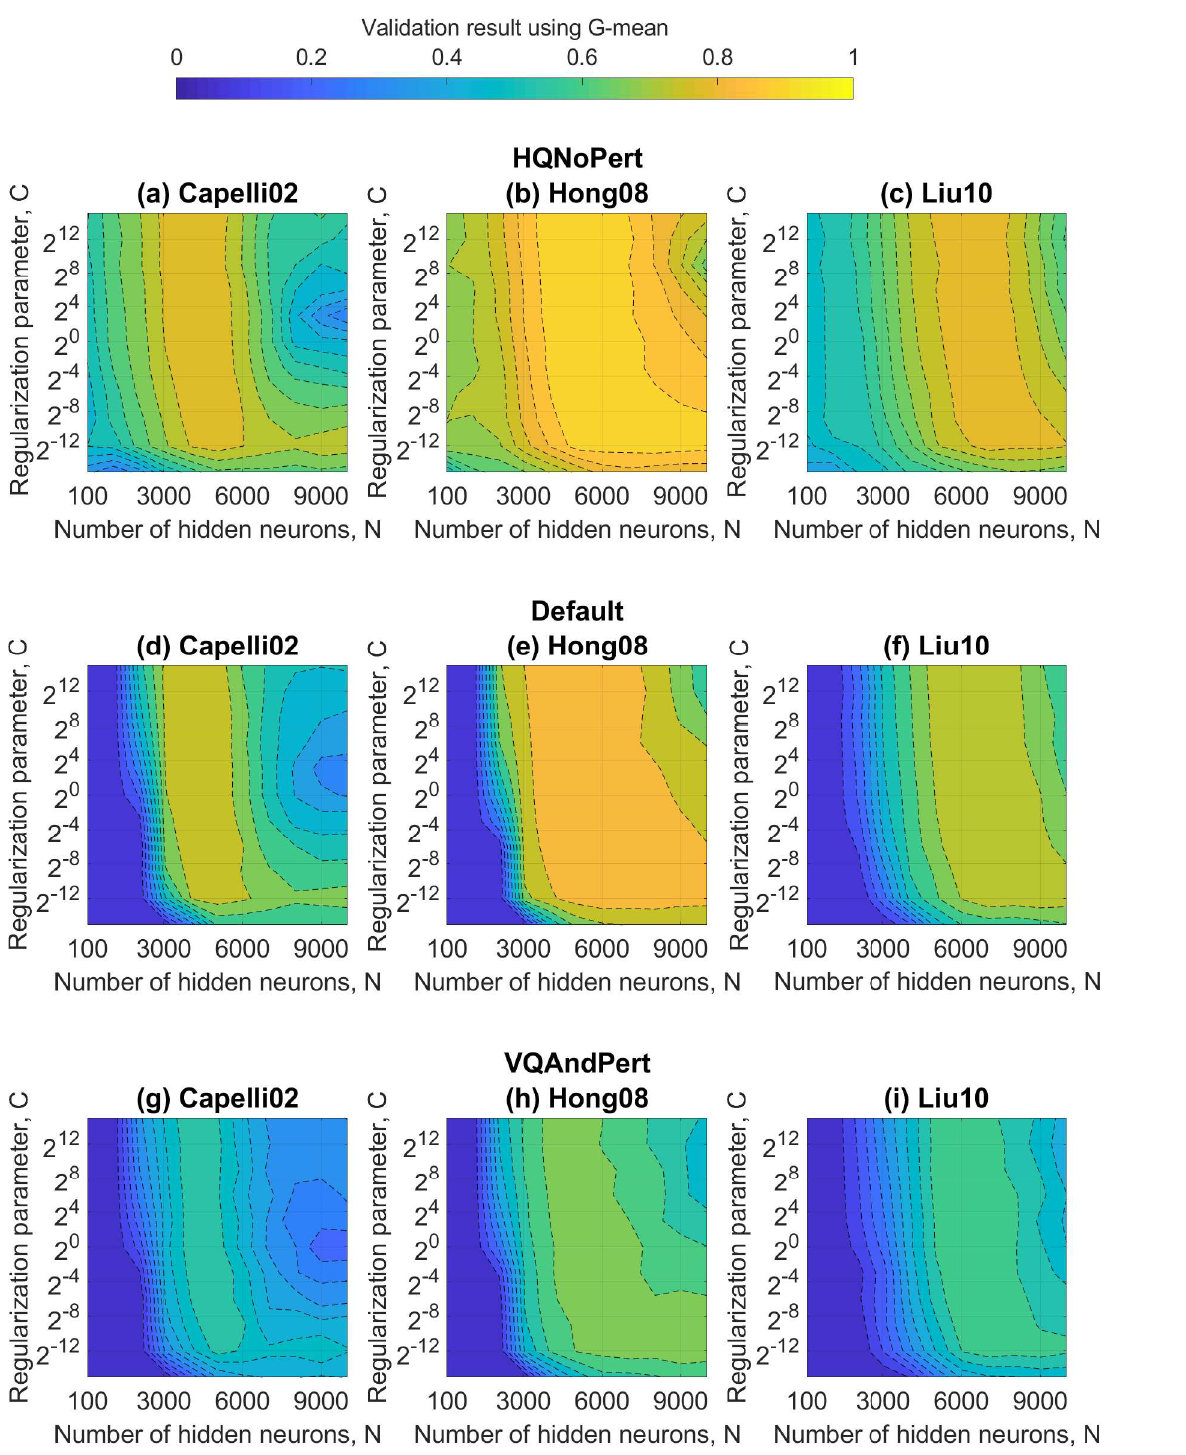
Figure 8. Validation results obtained by the W-ELM2as a function of the regularization parameter and number of hidden neurons. Each subfigure illustrates the database and feature